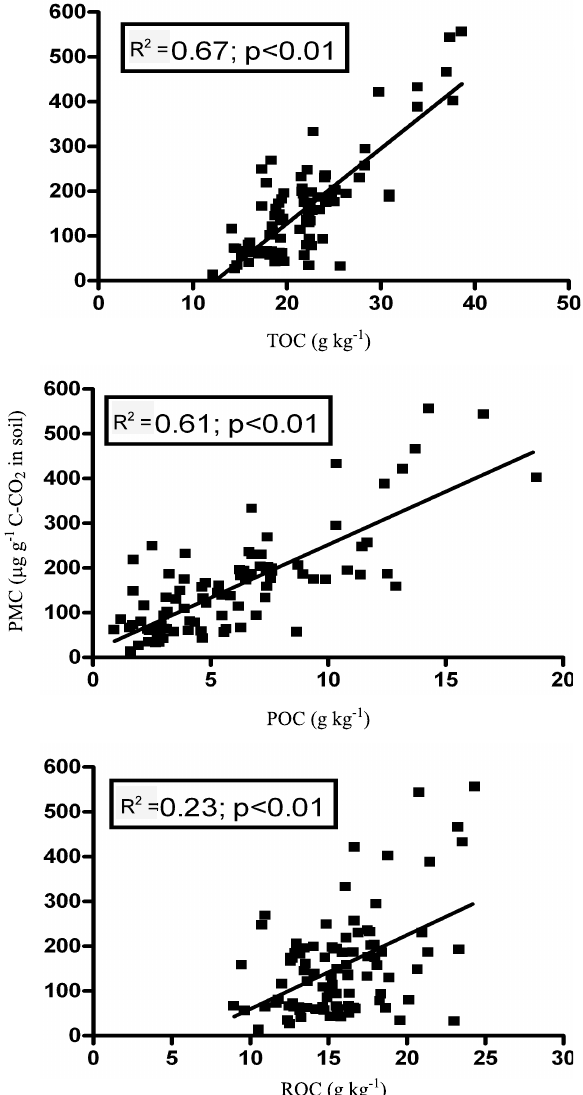
Figure 3. Relationship between potentially mineralizable carbon in 10 d (PMC) and (a) total carbon content (TOC), (b) particulate organic carbon (POC) and (c) resistant organic carbon